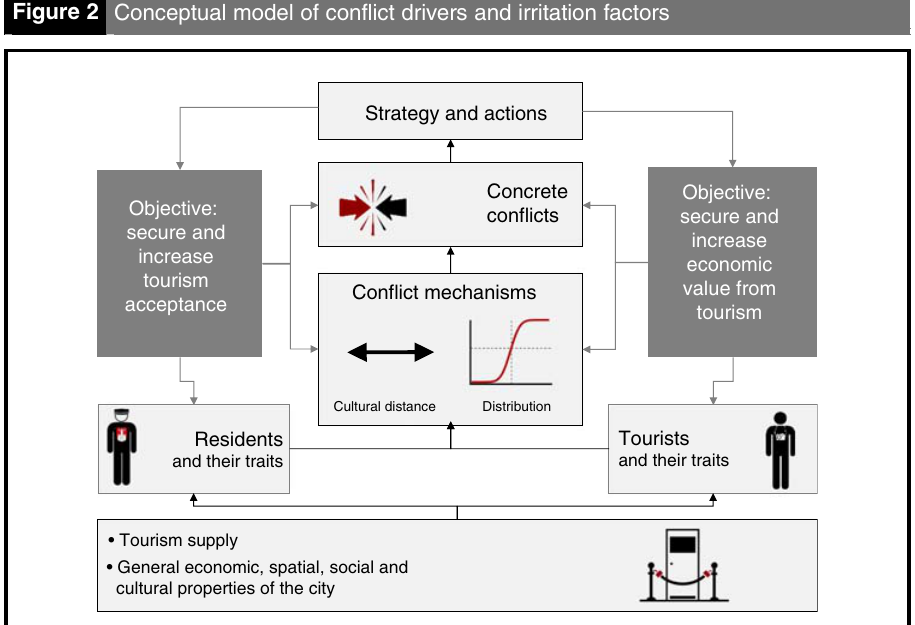
conflictsStrategy and